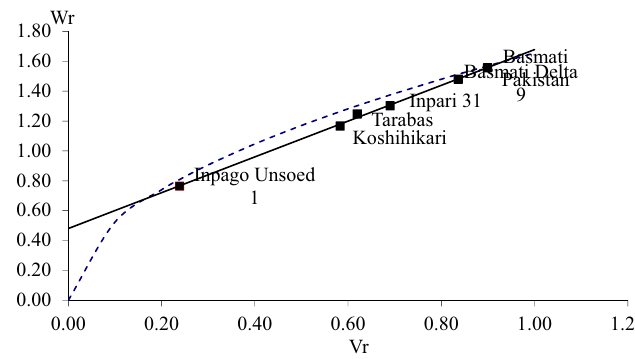
Figure 1: Covariance ( W r ) and variance ( V r ) graph of rice length.